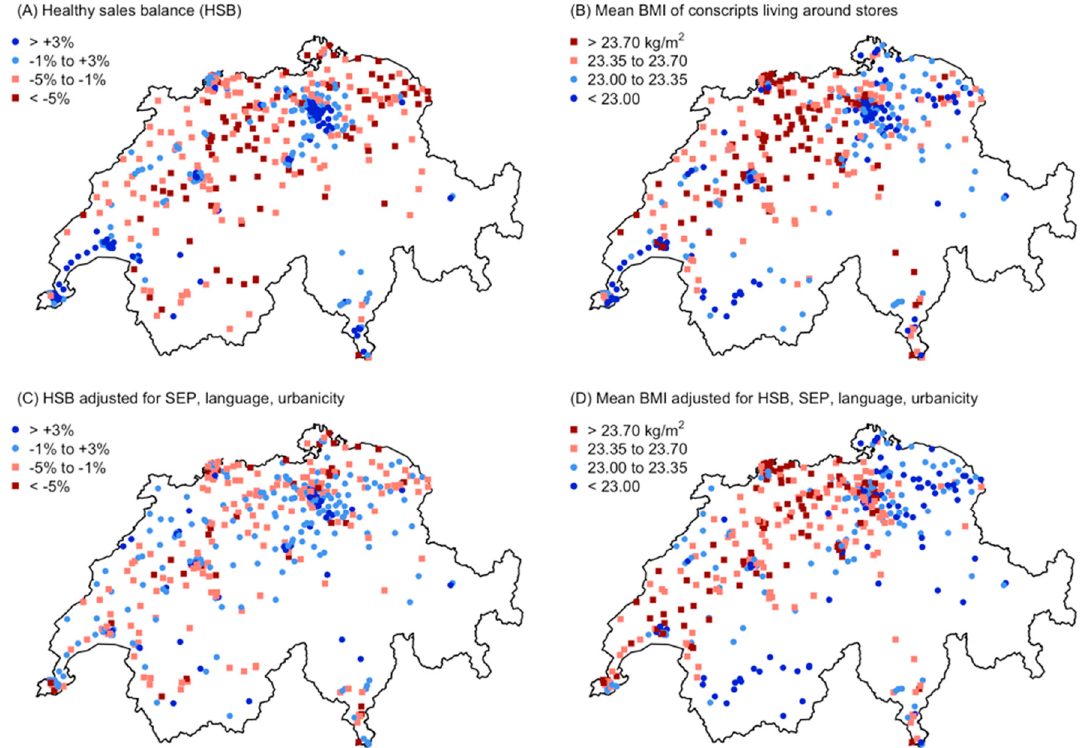
Figure 5. Spatial distribution of the healthy sales balance of the 445 stores and the mean BMI of conscripts living around the stores, either as raw data ( A , B ) or adjusted for the predictors in multiple regression models ( C , D ). Symbol colors represent values of HSB or BMI in four categories that approximately correspond to quartiles. Blue indicates healthy conditions (high HSB, low BMI). The spatial pattern in HSB ( A ) was largely accounted for by the regression model, so adjusted values show little spatial structure ( C ). In contrast, the spatial pattern in BMI ( B ) was poorly accounted for by the regression model, so adjusted values still show a pronounced spatial structure at the regional scale ( D ).